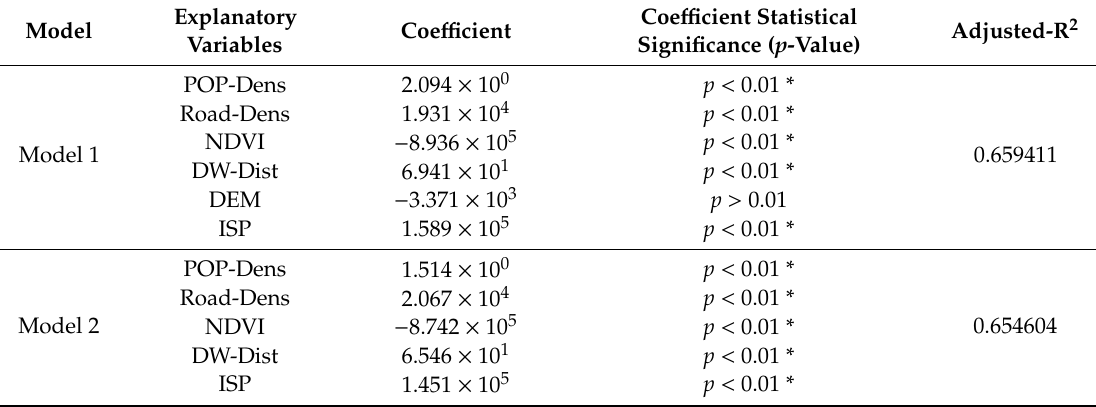
Table 2. Comparing relevant parameters of both ordinary least squares (OLS) models.